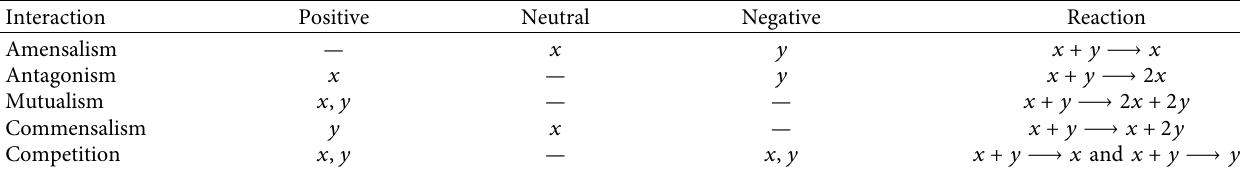
Table 1: Representing ecological interactions using reaction